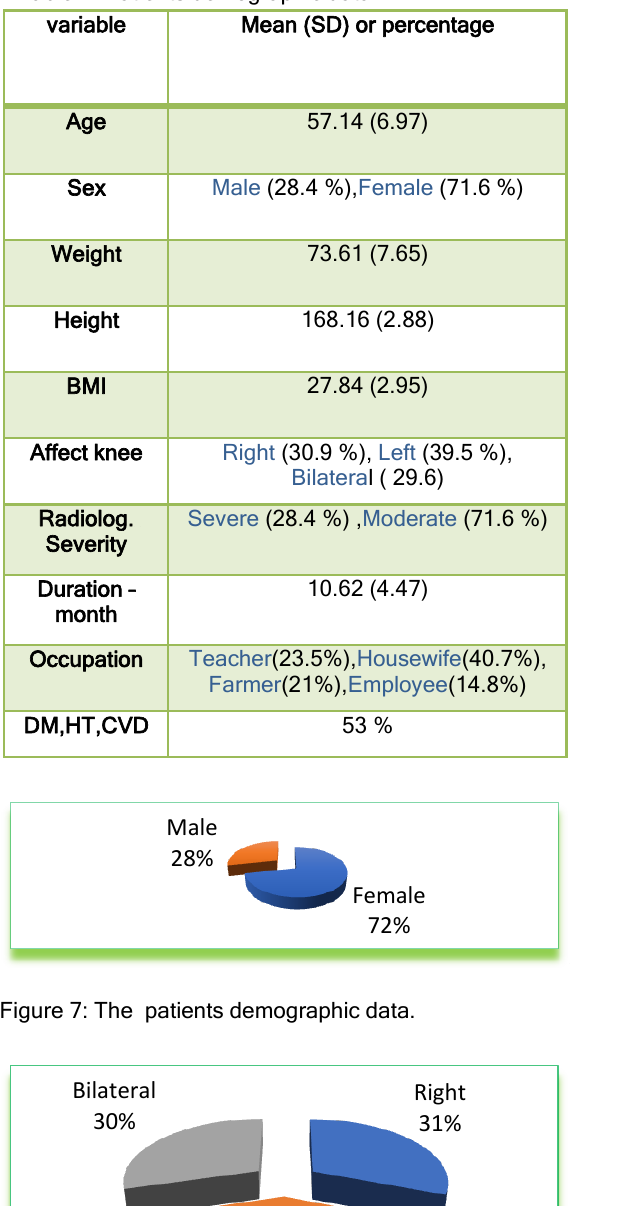
Table 1: Patients demographic data.